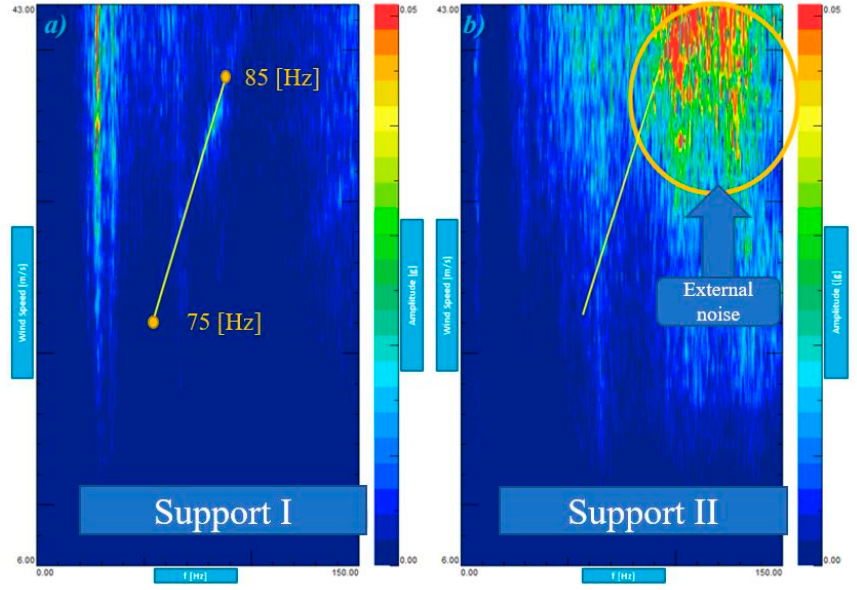
Figure 5. Comparison between accelerometers: ( a ) rigid neck; ( b ) hybrid neck 3.